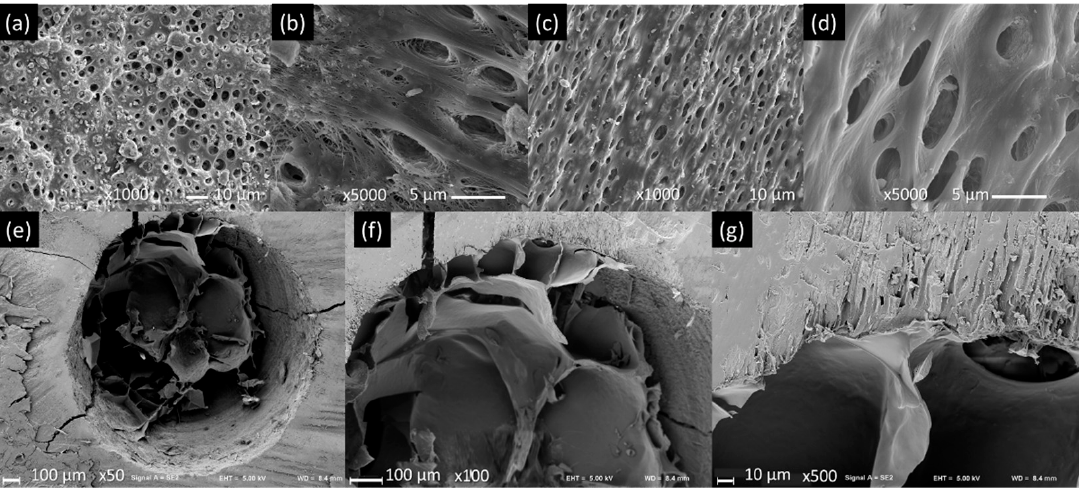
Figure 5. Hydrogel microstructure and interaction with dentin. Representative ( a ) dentin of the simulated root canals before the pre-conditioning observed under SEM at 1000× and ( b ) 5000×. ( c ) The same simulated root canal after pre-conditioning 1000× and ( d ) 5000×. ( e ) Simulated root canal filled with HAPL observed under SEM at 50×, ( f ) 100×, and ( g ) 500×. This is a figure. Schemes follow the same formatting.